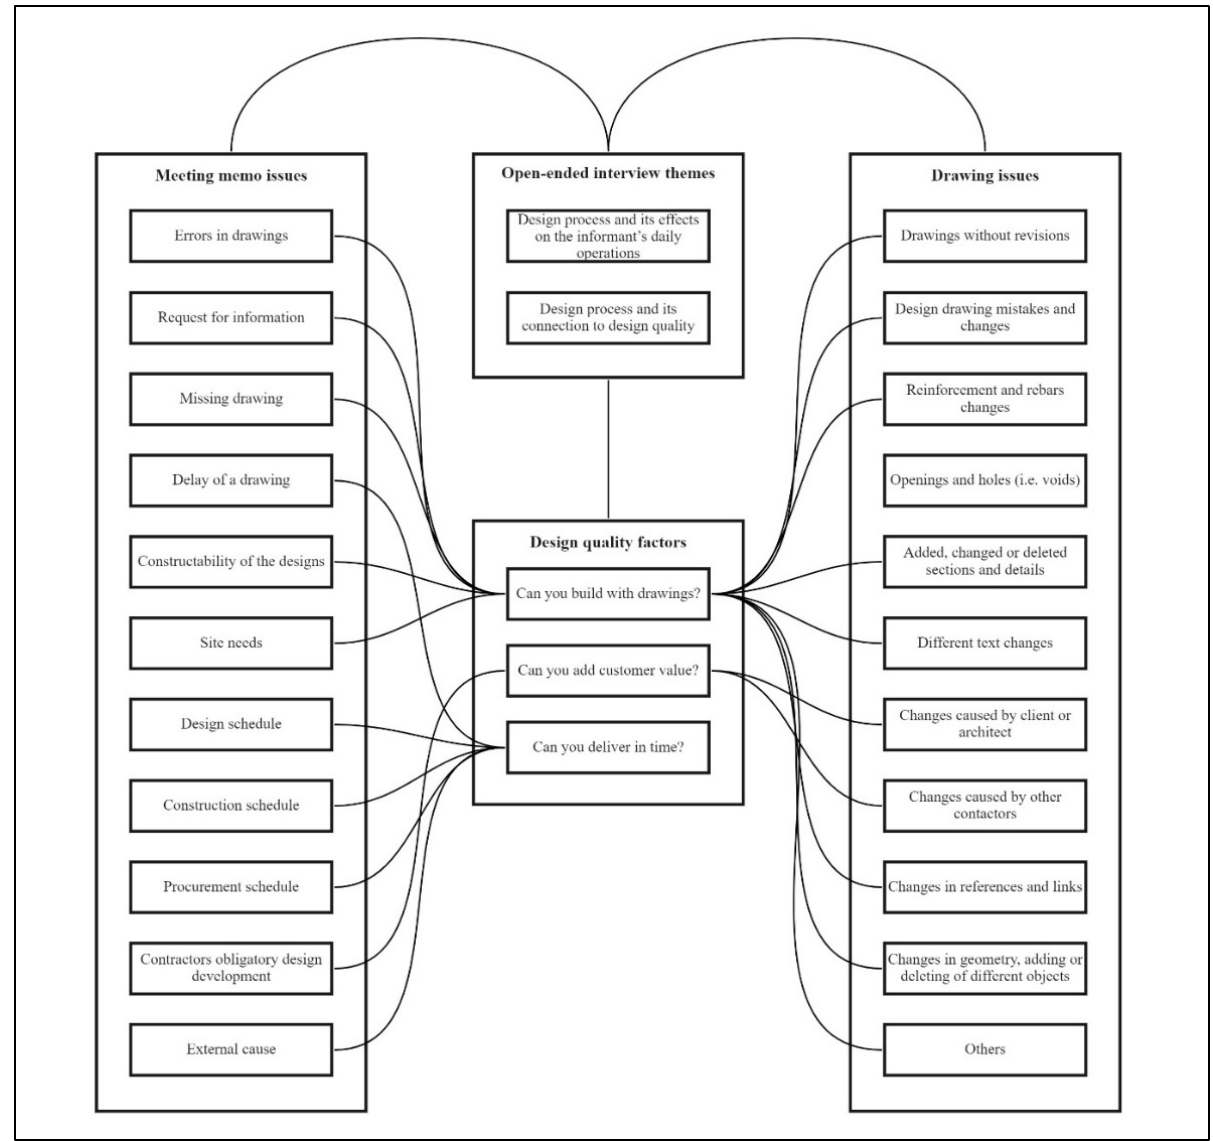
Figure 2. Coding hierarchy and connections between the design quality factors used in this study.